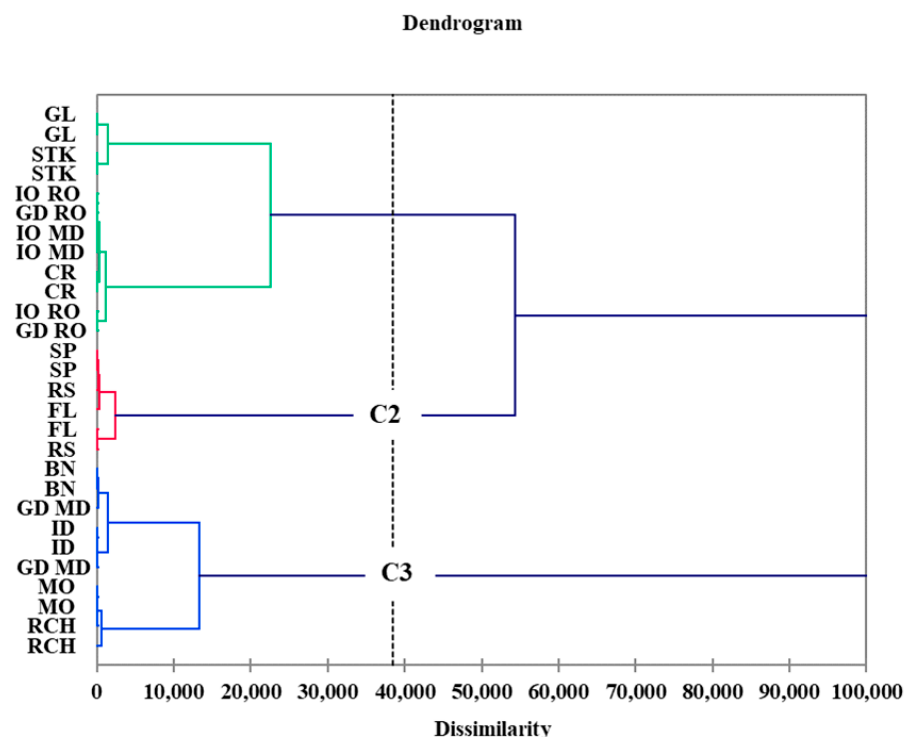
Figure 4. Dendrogram of the 12 apple cultivars based on triterpene composition. The results indicate that cultivars with a higher potential of polyphenols such as Starkrimson, Jonathan and Cretesti represent cultivars with a lower potential of triterpene acids. The cultivars with lower polyphenolic potential such as Montuan and Golden De- licious represent the cultivars with high triterpene acid content. Beliy Naliv, Golden Deli- cious and Richard apple cultivars shows both polyphenolic and triterpene acid potential.